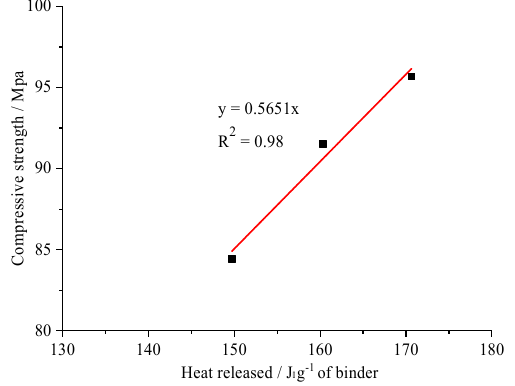
Figure 10. The linear regression results of heat released and the compressive strength of UHSCs at 3 days of age.